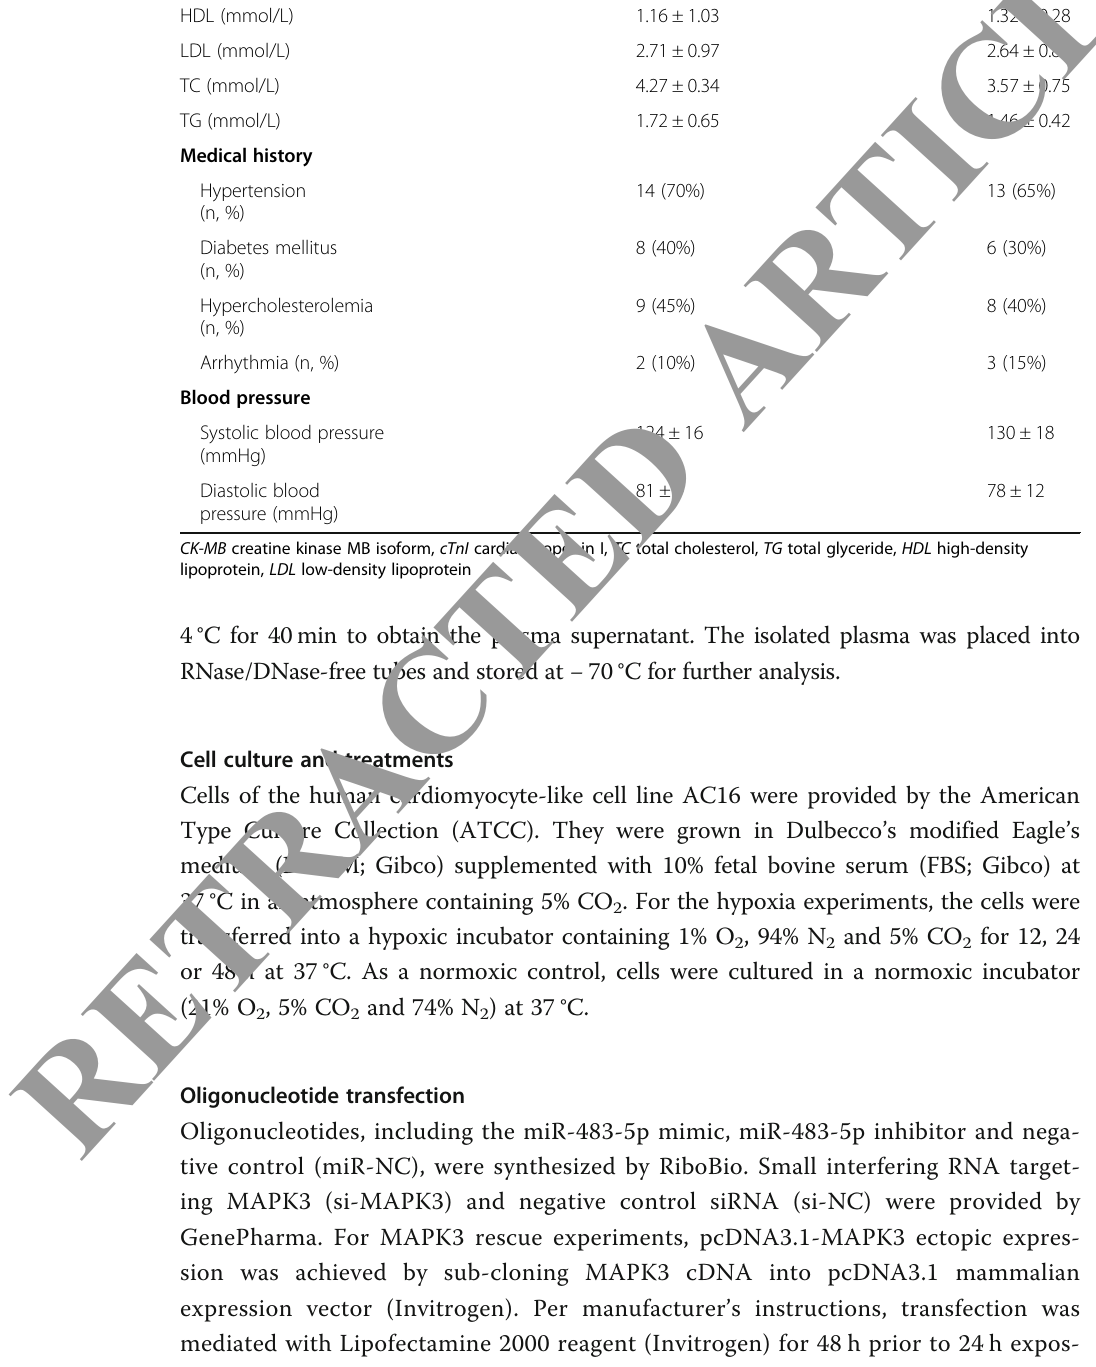
Oligonucleotide transfection